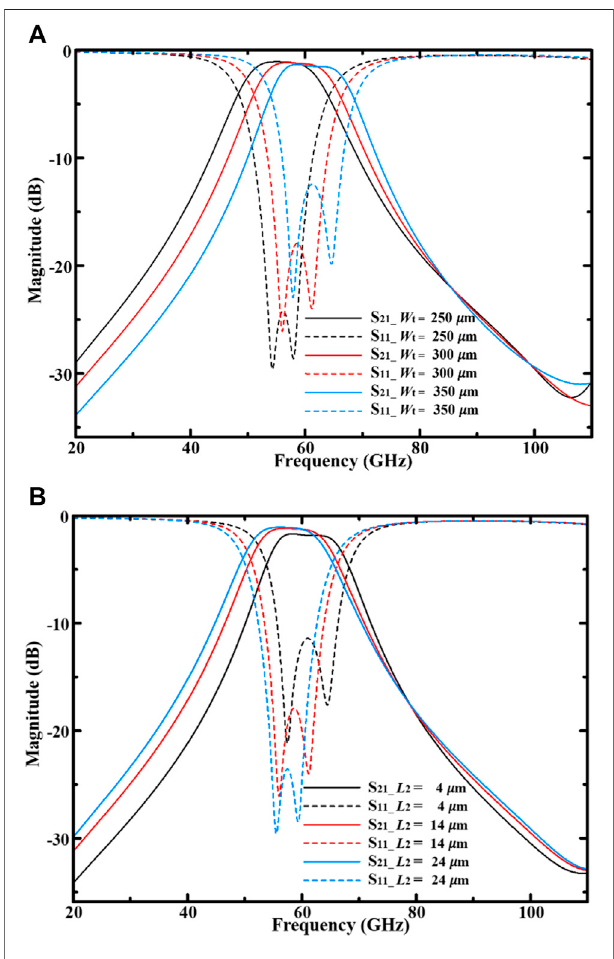
FIGURE 5 | S-parameters of the HMSIW BPF with (A) varied W t at L 2 (cid:3) 14 μ m and (B) varied L 2 at W t (cid:3) 318 μ m.